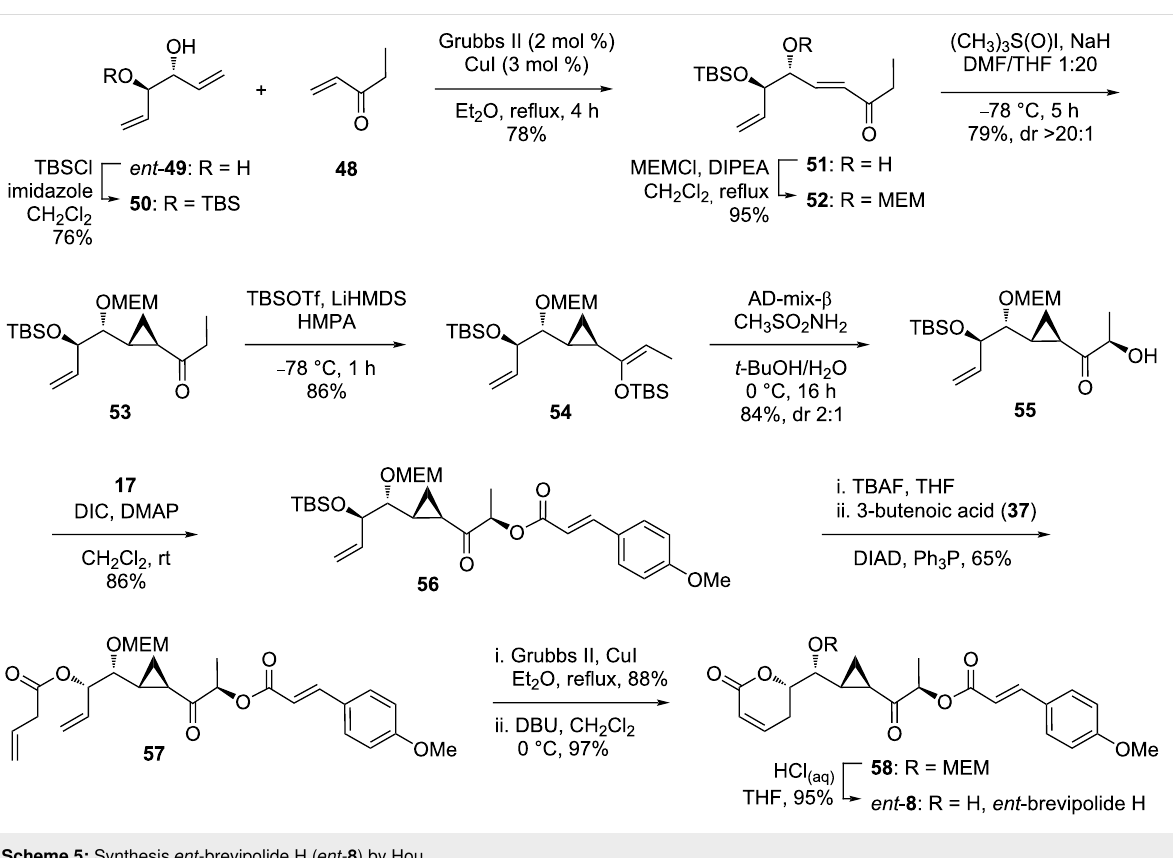
Scheme 5: Synthesis ent -brevipolide H ( ent - 8 ) by